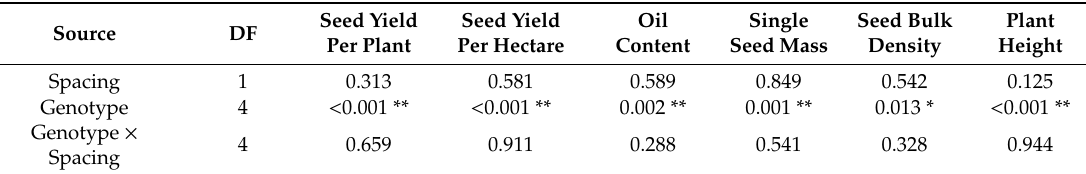
Table 6. P values of e ff ects from analysis of variances at Batchenga (3rd year, DF = degrees of freedom). Seed Yield Source DF Per